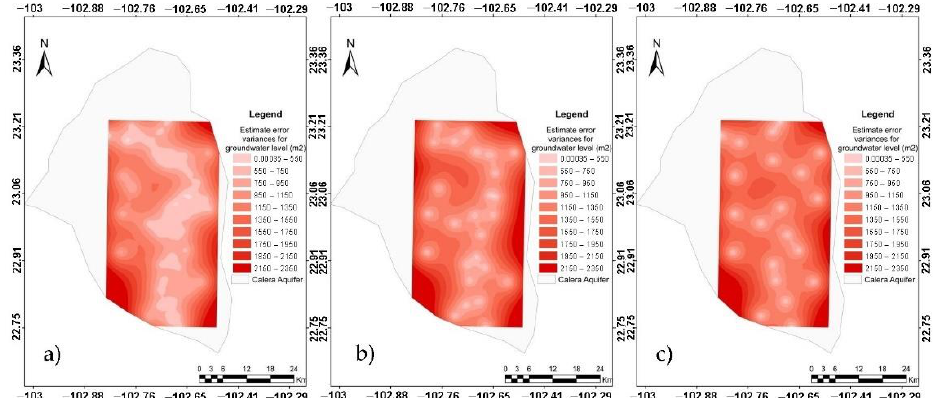
Figure 11. Estimate error variances for groundwater levels considering: ( a ) the complete network, ( b ) the proposed method, and ( c ) the Júnez-Ferreira method.